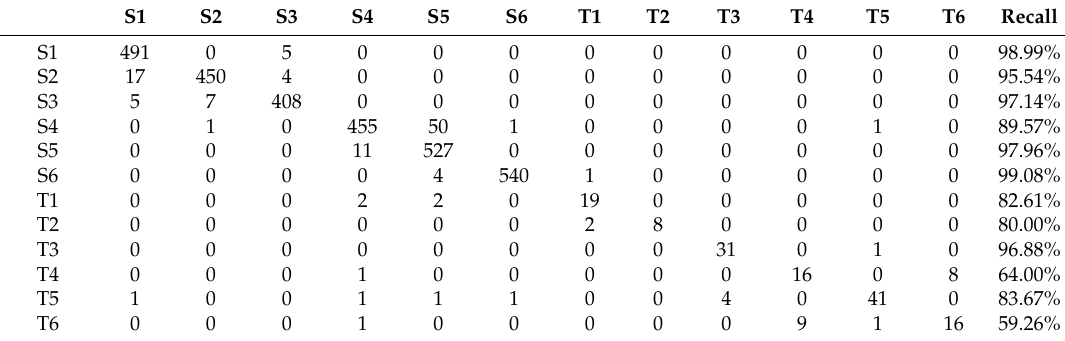
Table 3. Confusion matrix related to the MANN classification with respect to all activities belonging to the SBHAR dataset; S1: walking, S2: walking upstairs, S3: walking downstairs, S4: sitting, S5: standing, S6: laying, T1: stand-to-sit, T2: sit-to-stand, T3: sit-to-lie, T4: lie-to-sit, T5: stand-to-lie, T6: lie-to-stand.